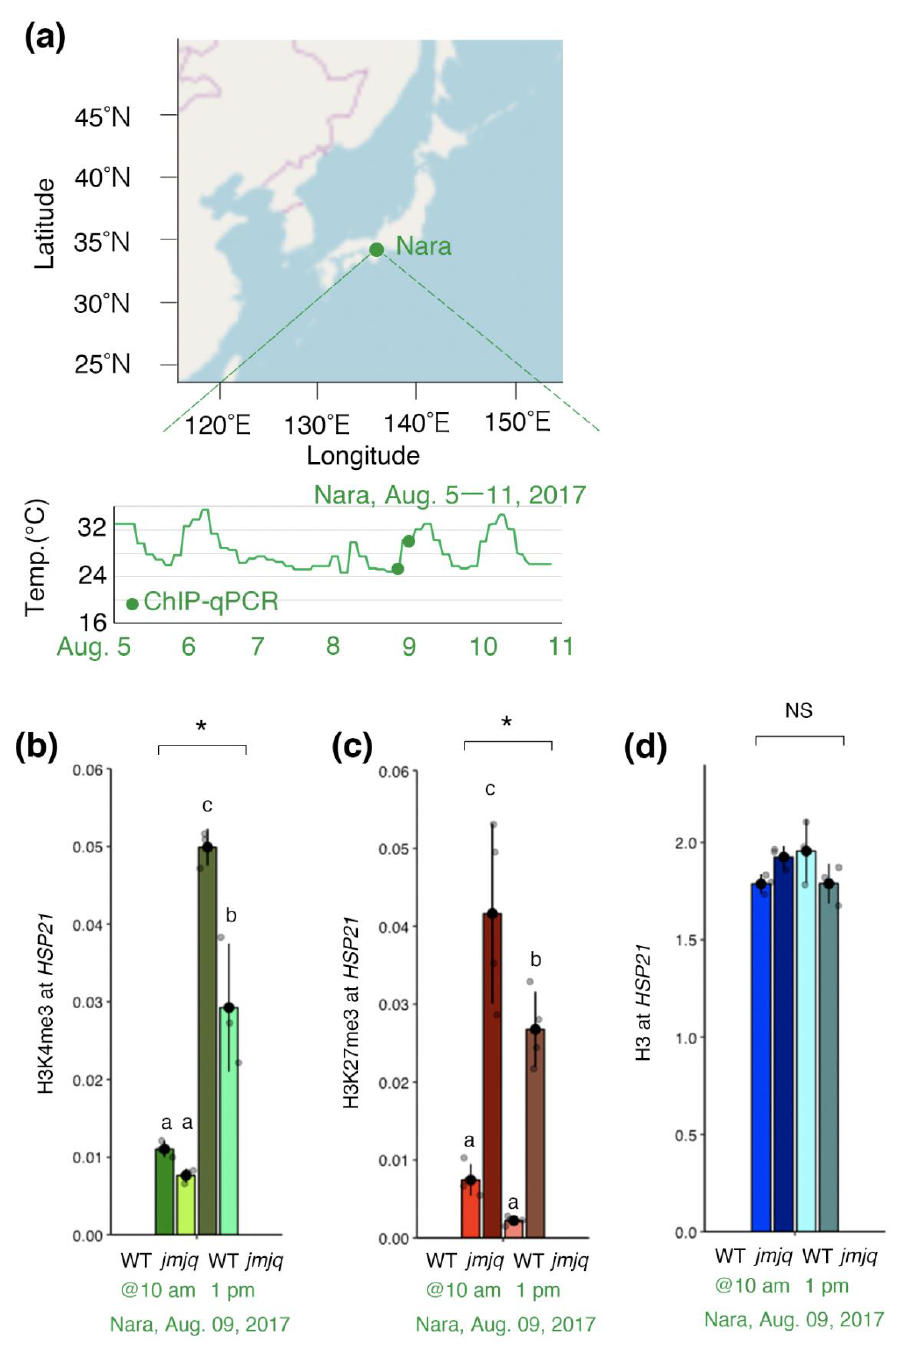
Figure 4. Jumonji demethylases are required for the removal of histone H3K27me3 from the HSP21 gene under the fluctuating Nara conditions. ( a ) Location of the city of Nara in Japan (above). Schematic representation of the temperature conditions in Nara (below). Timing of ChIP–qPCR is denoted by the green dot. ( b – d ) H3K4me3 ( b ), H3K27me3 ( c ), and histone H3 ( d ) levels at the HSP21 gene in the wild type and jmjq mutants as determined by ChIP–qPCR. Gray jitter dots represent the expression level in each sample. Asterisks indicate significant differences based on one-way ANOVA test (* p < 0.05). The letters above the bars indicate significant differences, while the same letters indicate non-significant differences (post-hoc Tukey’s HSD test ( p < 0.05)). NS, not